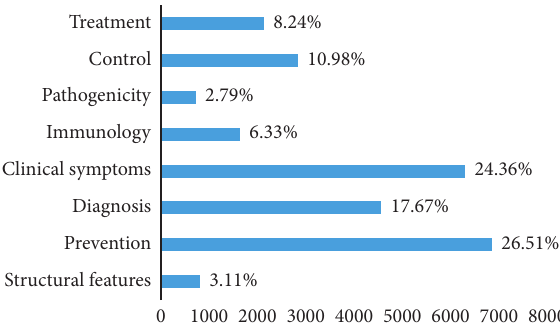
Figure 3: Publication rates of each of the brucellosis publications. Table 1: Subtopics obtained for each of the main topics of the brucellosis